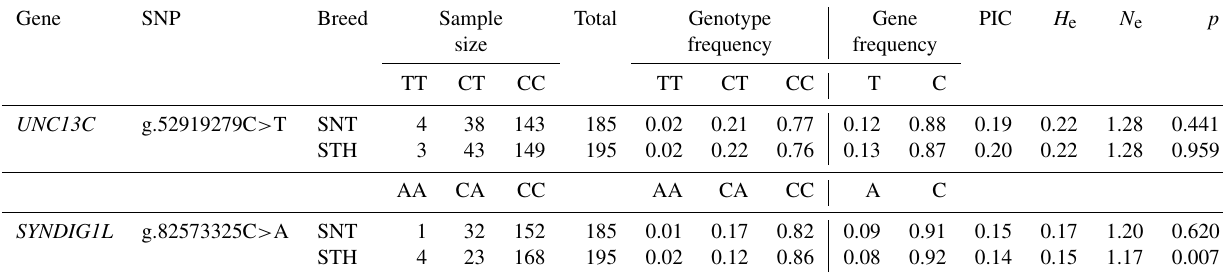
Table 4. Population genetic analysis of candidate loci in two sheep breeds. Gene SNP Breed Sample Total Genotype Gene